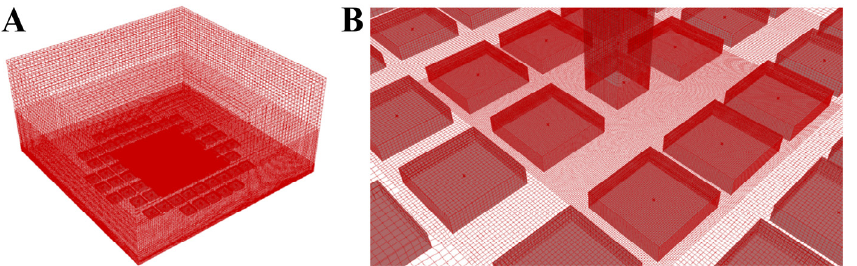
Figure 3. ( A ) Hexahedral box computational domain; ( B ) the multi-area meshes were encrypted so that the mesh size increases with the distance from the central building.